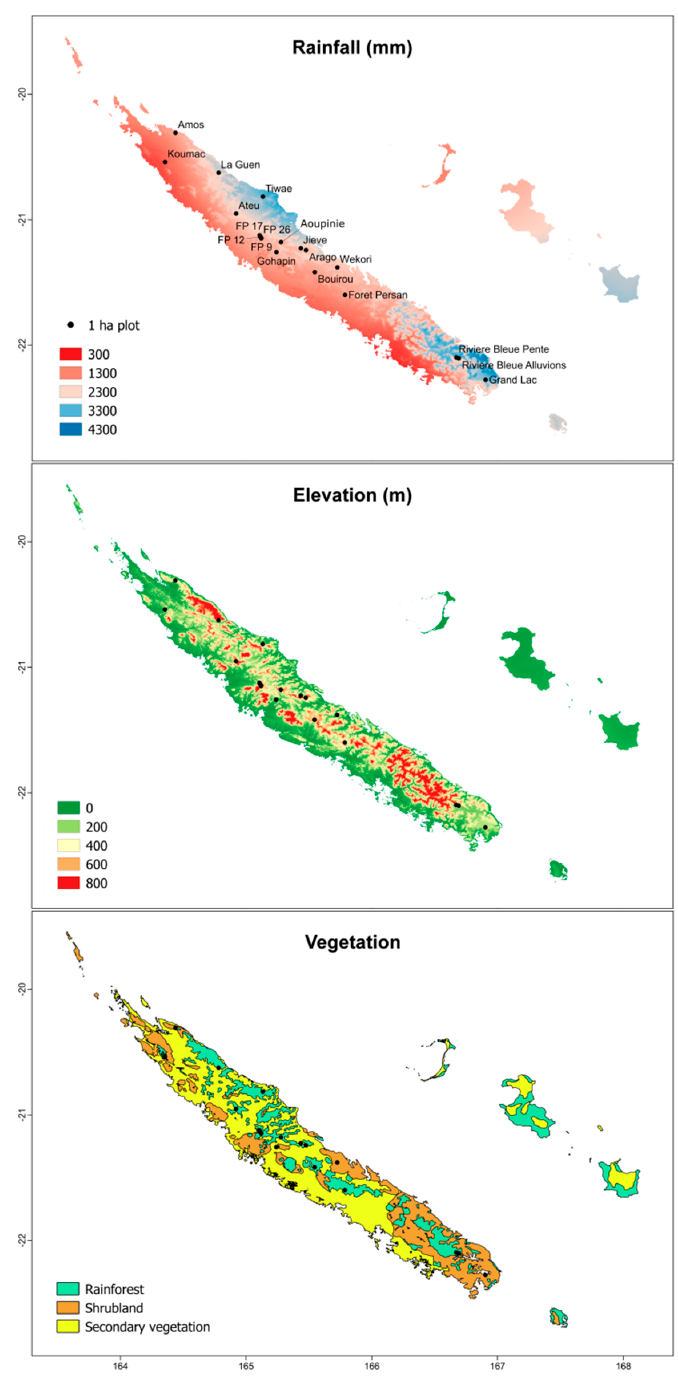
Figure 1. Geographical and environmental distributions of the 19 one hectare plots used to examine the NDVI-tree species richness relationship in New Caledonia.